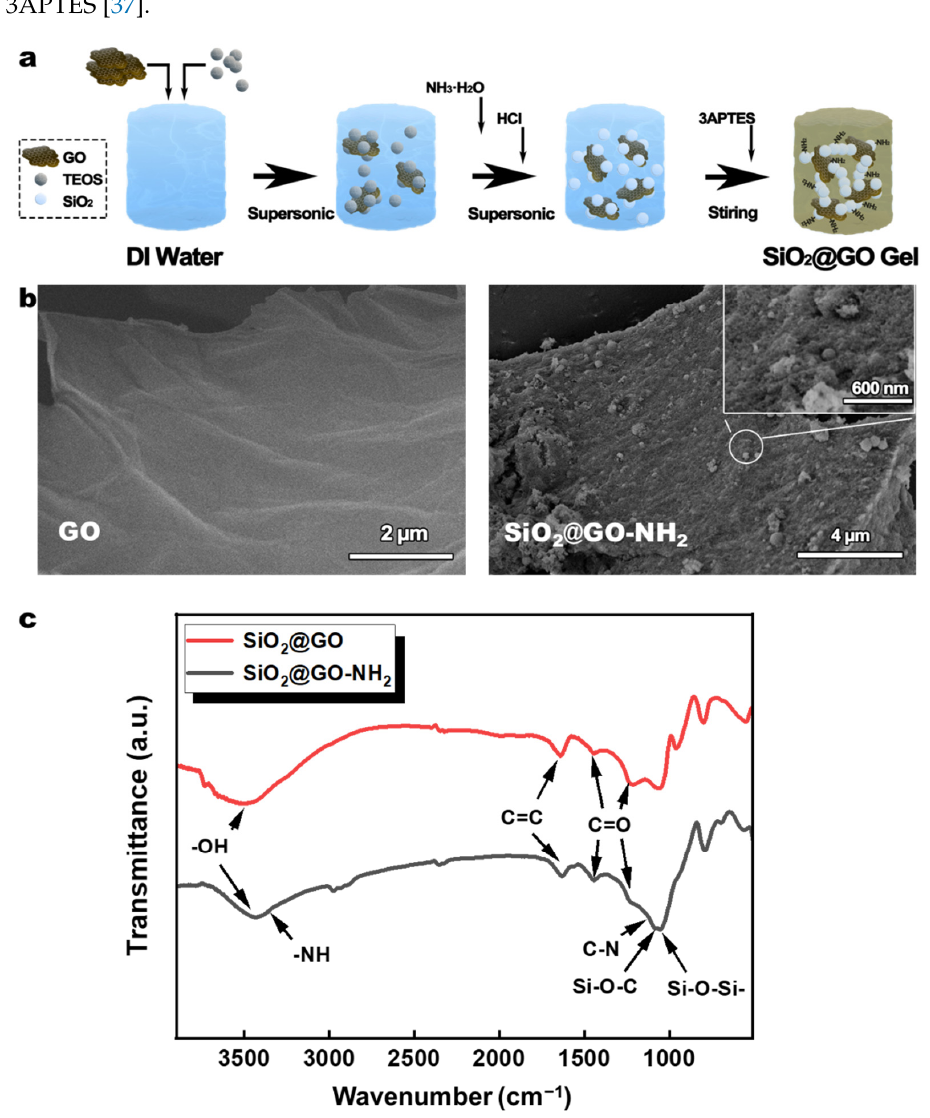
Figure 1. ( a ) Preparation process of SiO 2 @GO-NH 2 wet gel. ( b ) SEM images of GO and SiO 2 @GO- NH 2 . ( c ) FT-IR spectra of SiO 2 @GO and SiO 2 @GO-NH 2 .